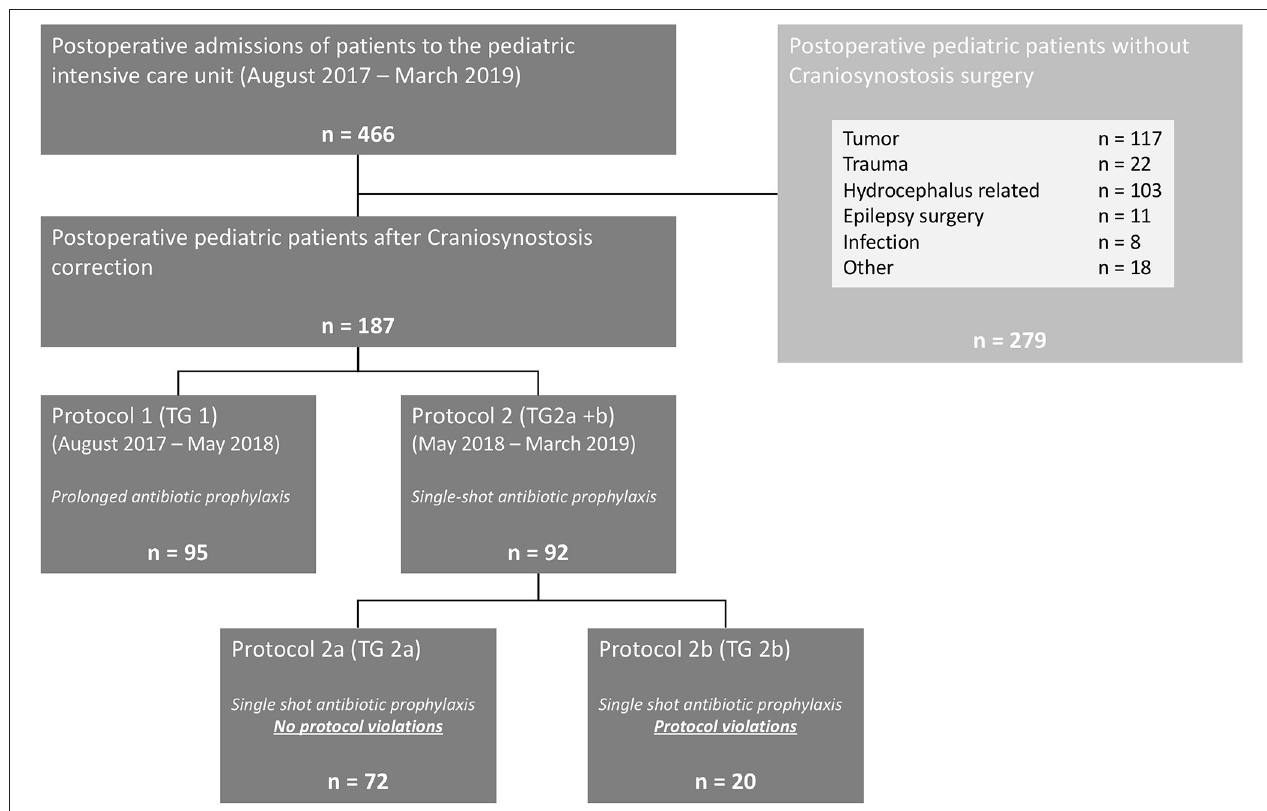
FIGURE 2 | Study design and characteristics. TG, treatment